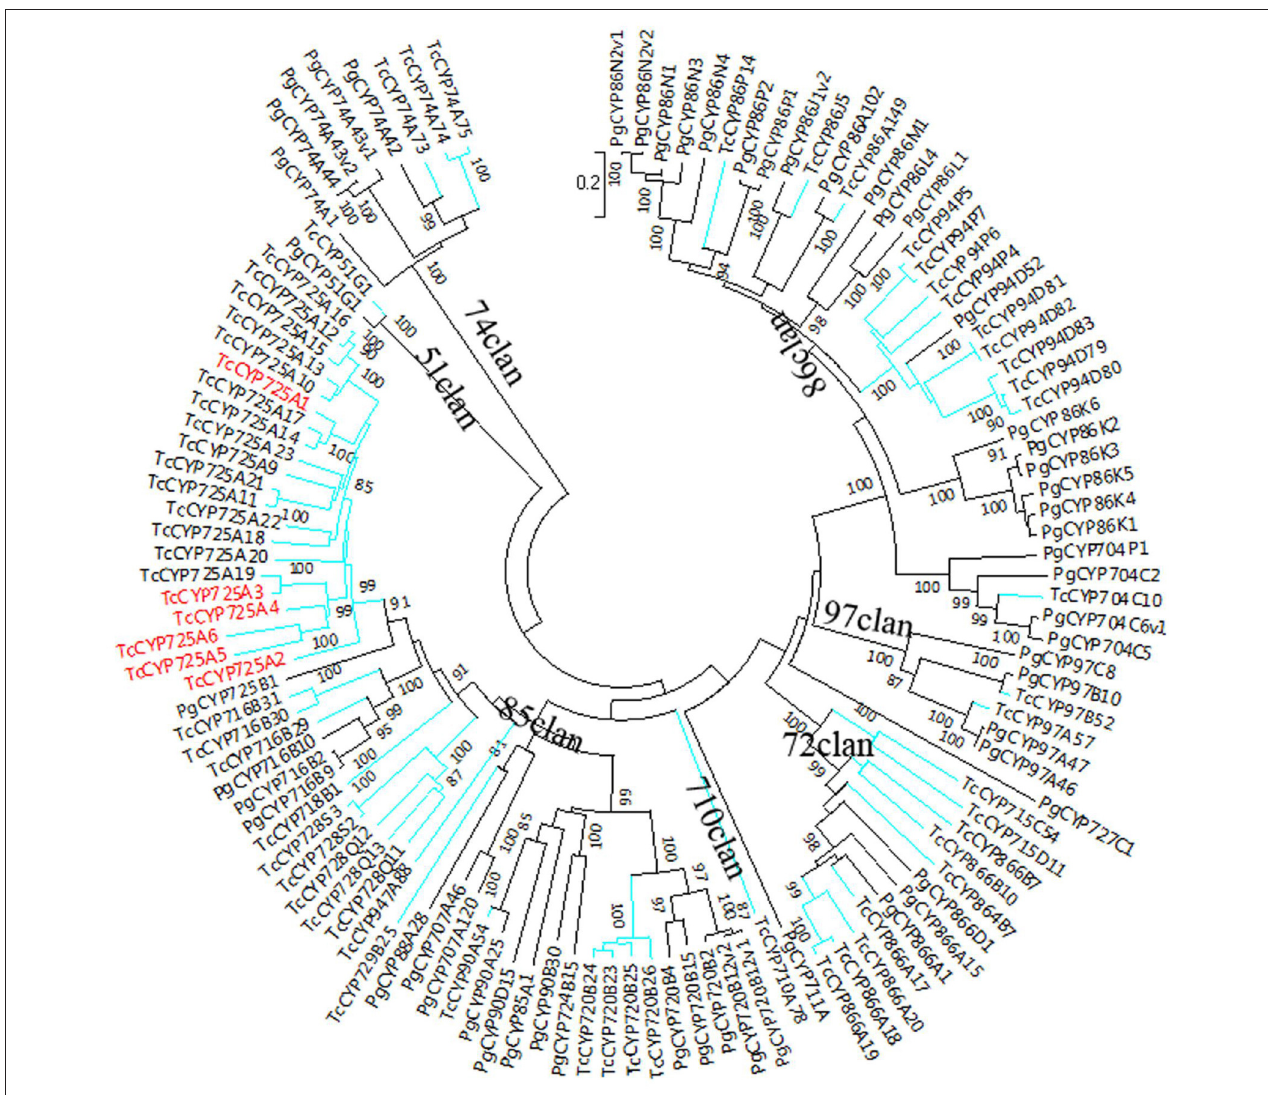
FIGURE 2 | Phylogenetic tree of non-A-type CYP450 proteins from T. chinensis (Tc) and P. glauca (Pg). The spokes corresponding to Tc and Pg CYP450s are shown in blue and black, respectively. The genes marked in red are described in the